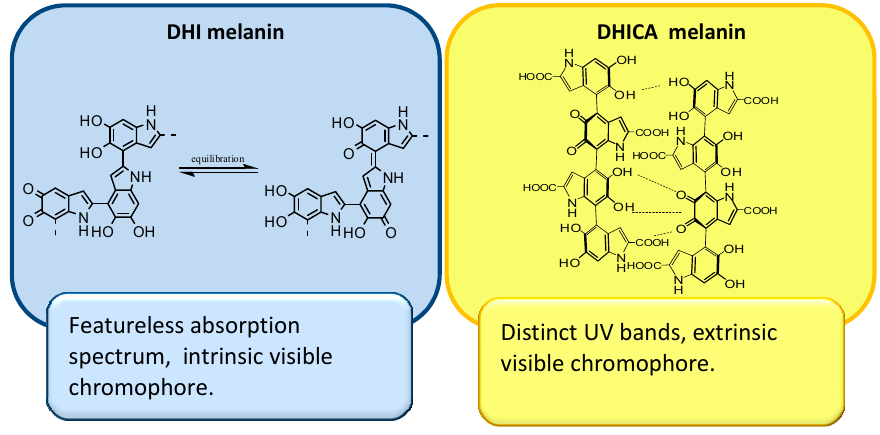
Figure 5. Intrinsic and extrinsic contributions to the chromophoric properties of DHI and DHICA melanin.